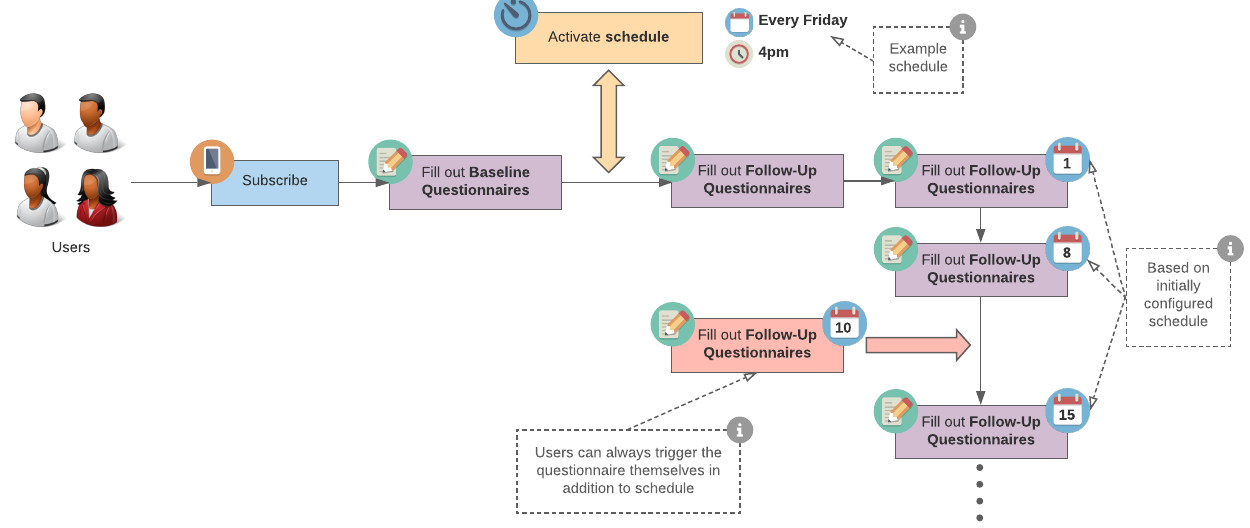
Figure 3. Notification scheduling in Corona Health. After the baseline questionnaire is filled out, the notification schedule for the selected study is activated. Notifications will be triggered based on the given schedule. Additionally, the user can always fill out additional follow-up questionnaires by manually accessing